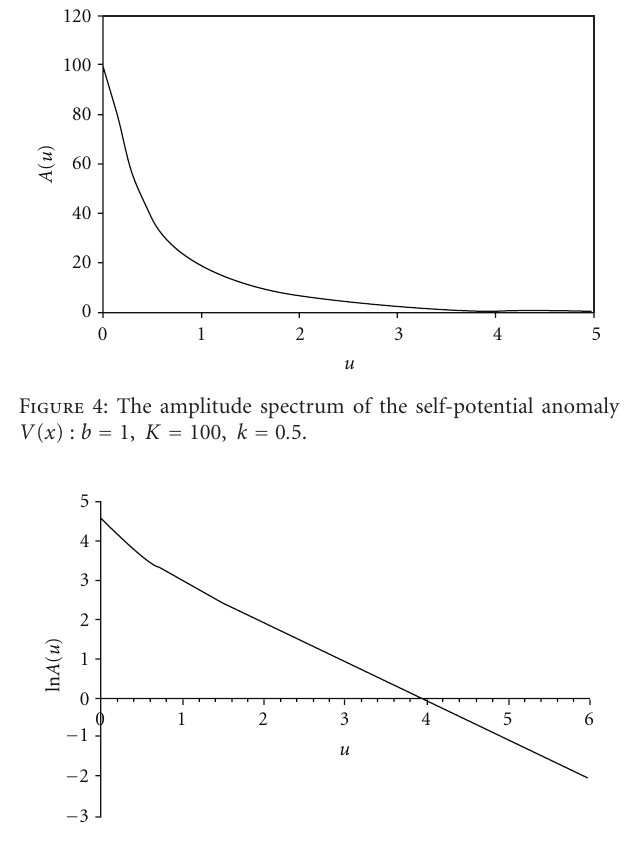
Figure 5: The natural logarithm of amplitude A against spatial frequency u